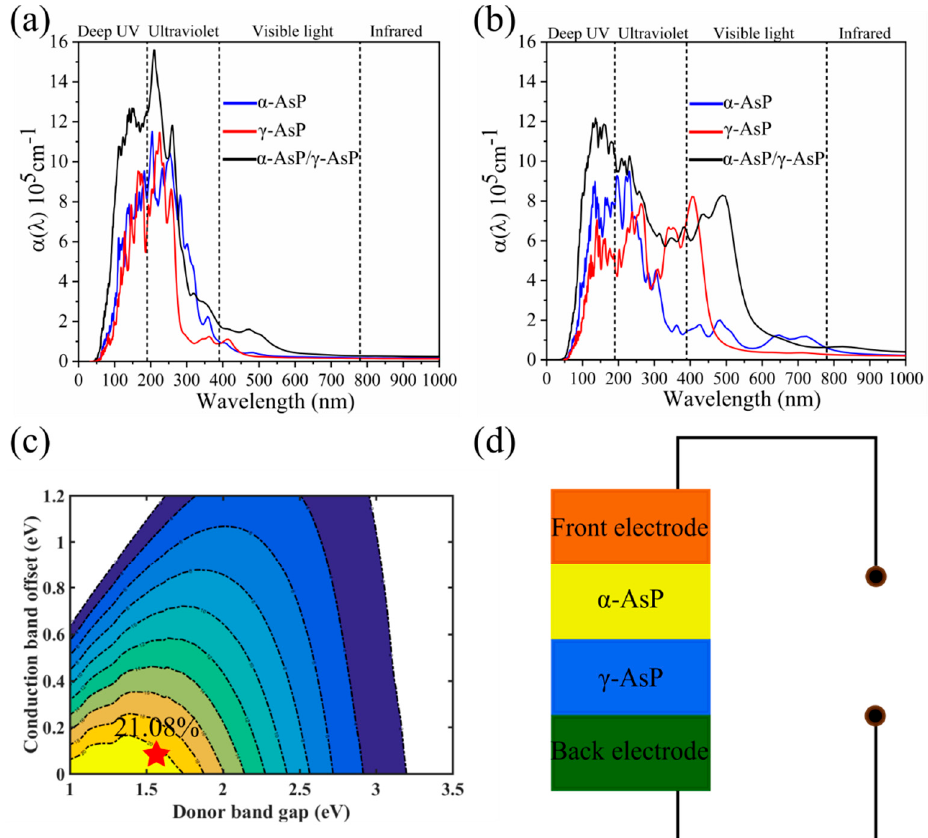
Figure 4. The optical absorption coefficient α of the α -AsP/ γ -AsP homojunction in ( a ) zigzag direction and ( b ) armchair direction. ( c ) The computed PCE (%) of α -AsP/ γ -AsP homojunction is indicated by the red star. ( d ) Schematic diagram of a solar thin-film cell. (The above calculations are based on HSE06).